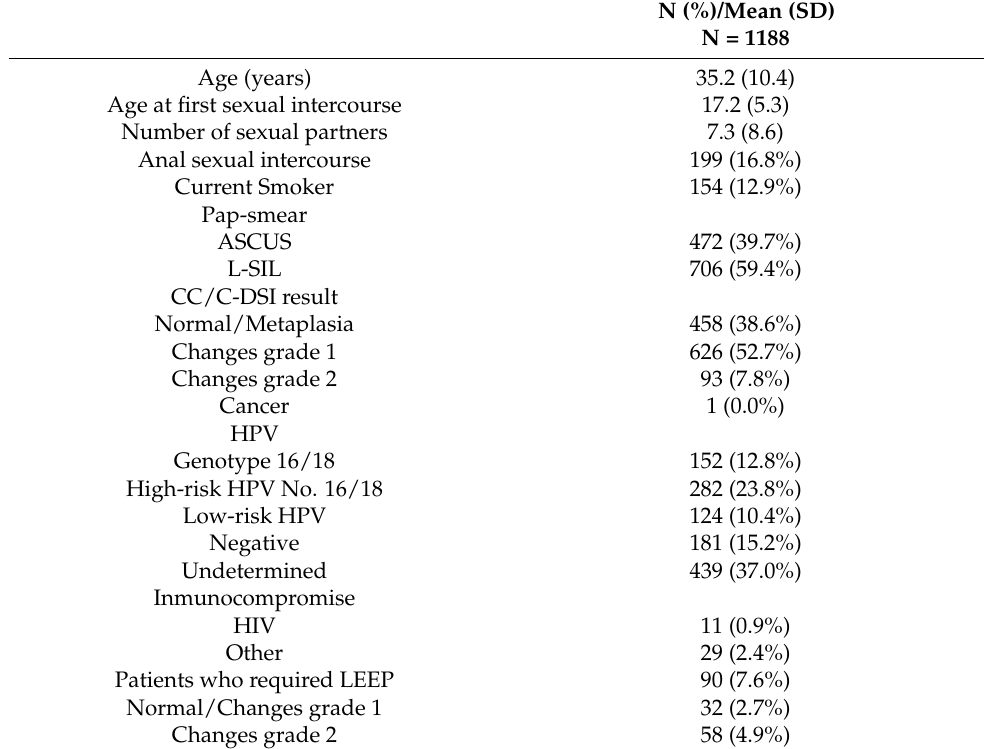
Table 1. Main characteristics of the cohorts.